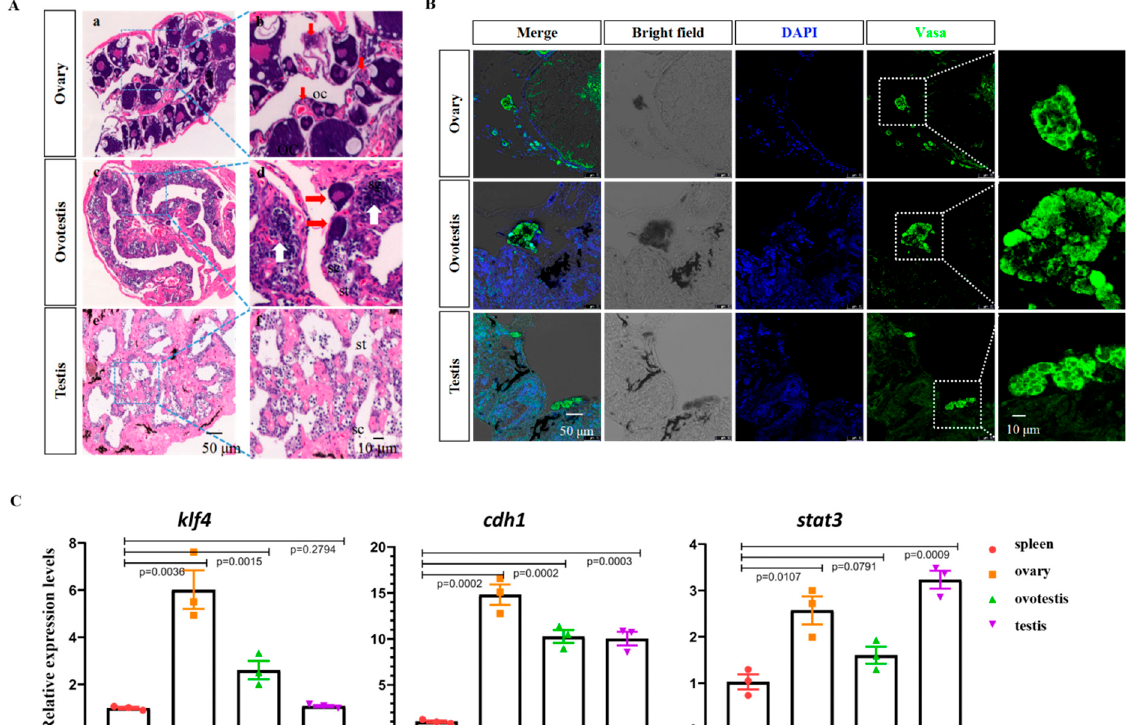
Figure 1. Identification of swamp eel germline stem cells at different stages. ( A ) H&E staining of ovary ( a , b ), ovotestis ( c , d ), and testis ( e , f ) tissues. Red arrows show the oocytes of different stages, and white arrows show the spermatocytes. oc: oocyte; sg: spermatogonia; st: round spermatids. ( B ) Confocal images showing the Vasa-positive cells in the adult ovary, ovotestis, and testis. ( C ) qRT-PCR results showing the expression of pluripotency and GSC marker genes in different types of